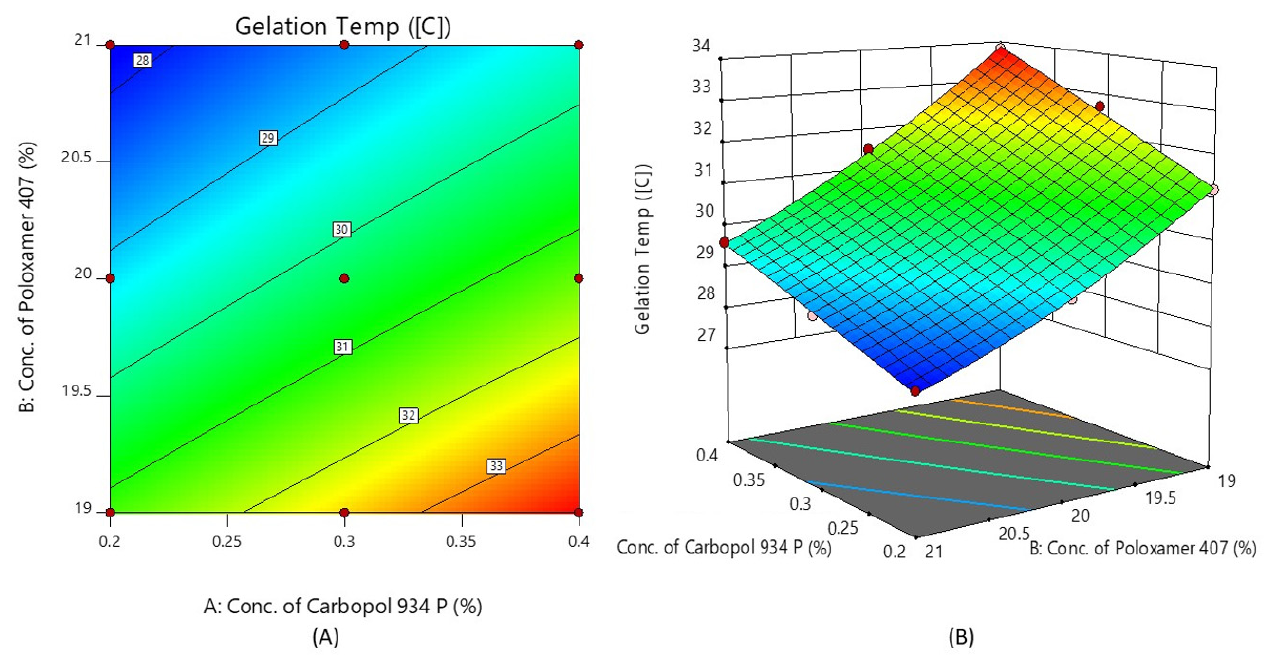
Figure 4. Contour plot ( A ) and 3D surface plot ( B ) show the effects of the concentrations of Carbopol 934P and Poloxamer 407 on gelation temperature.